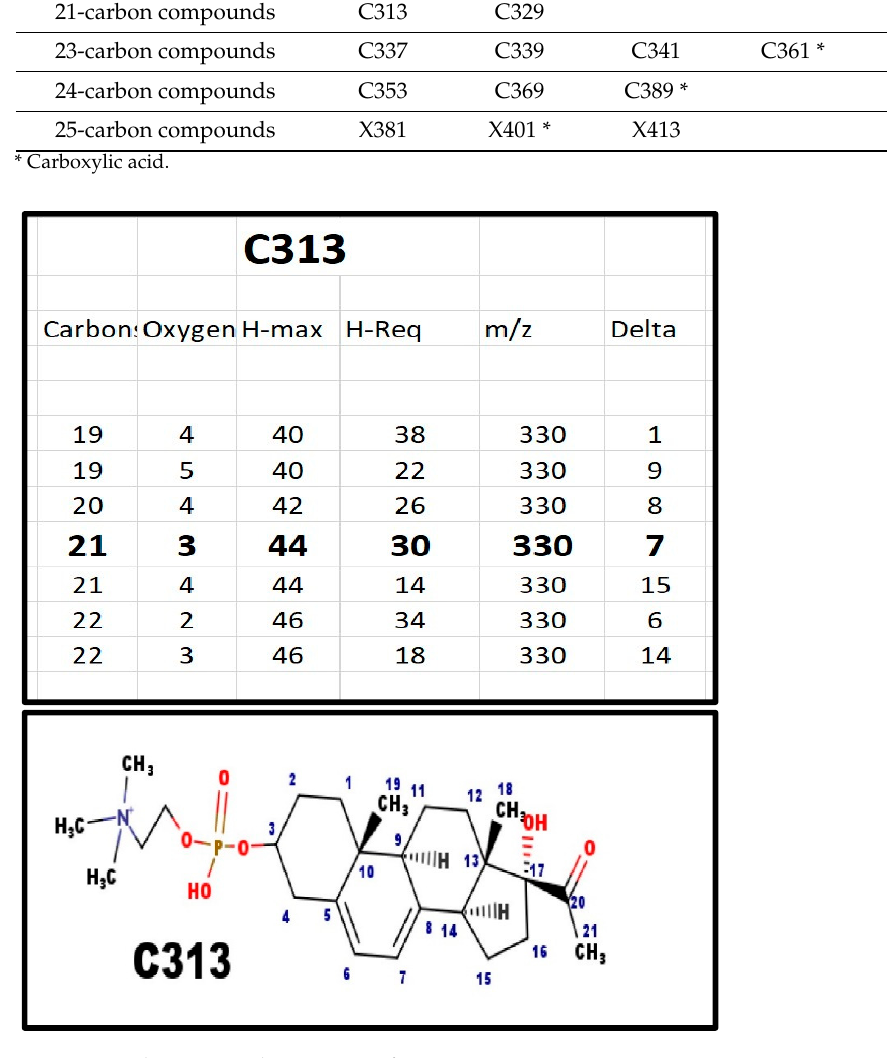
precursors of all of the phosphodiester steroids.